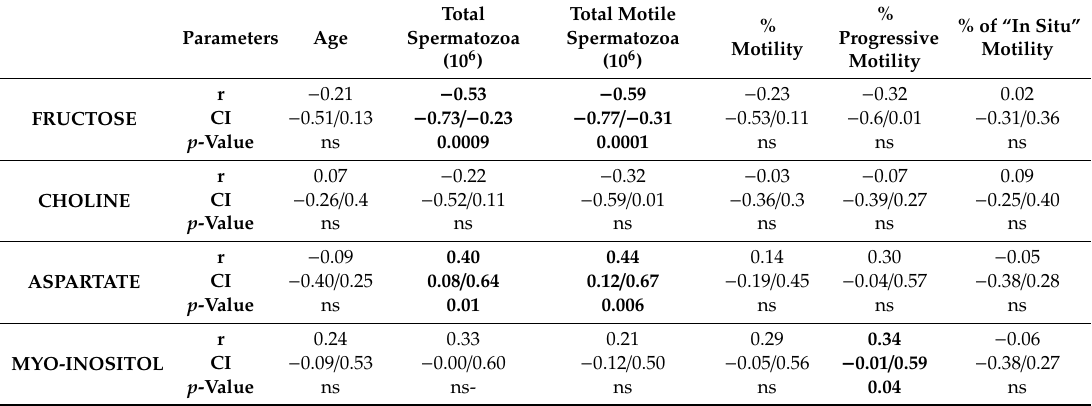
Table 3. Summary of the statistical parameters of the Spearman correlation of fructose, choline, aspartate and myo-inositol with the clinical parameters of the patients. Bold values indicated significant